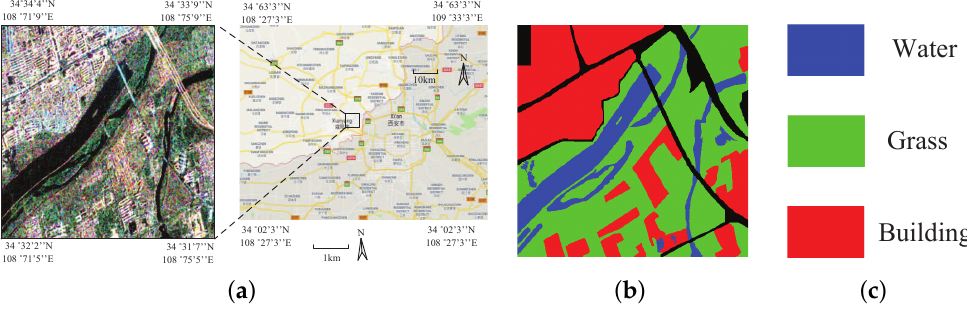
Figure 3. Xi’an. ( a ) Left: PauliRGB image with its coordinate, right: the photo of the near area with its coordinate, which is from Google Maps. ( b ) Ground truth map. ( c ) Color code.